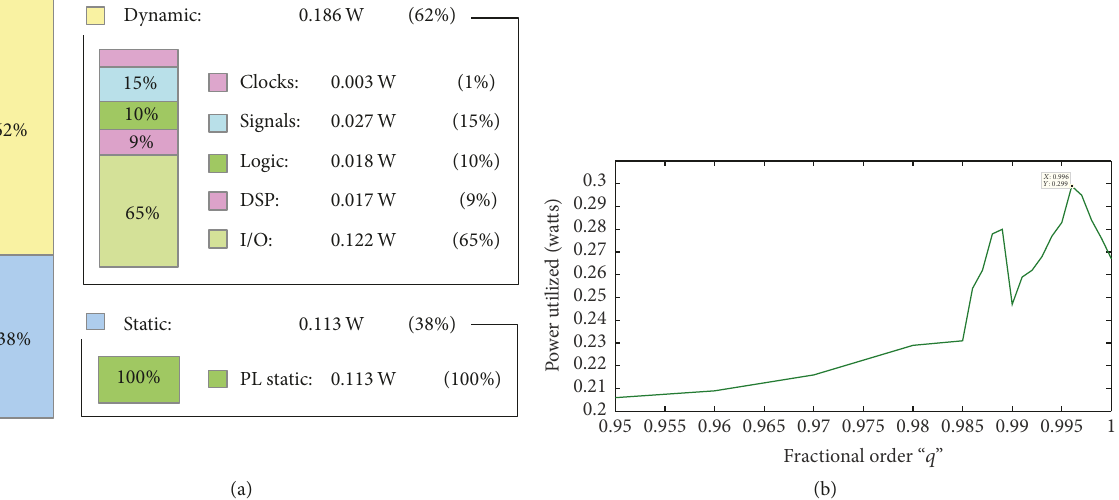
Figure 21: (a) Power utilized and (b) power utilization versus fractional order of FONCS-2